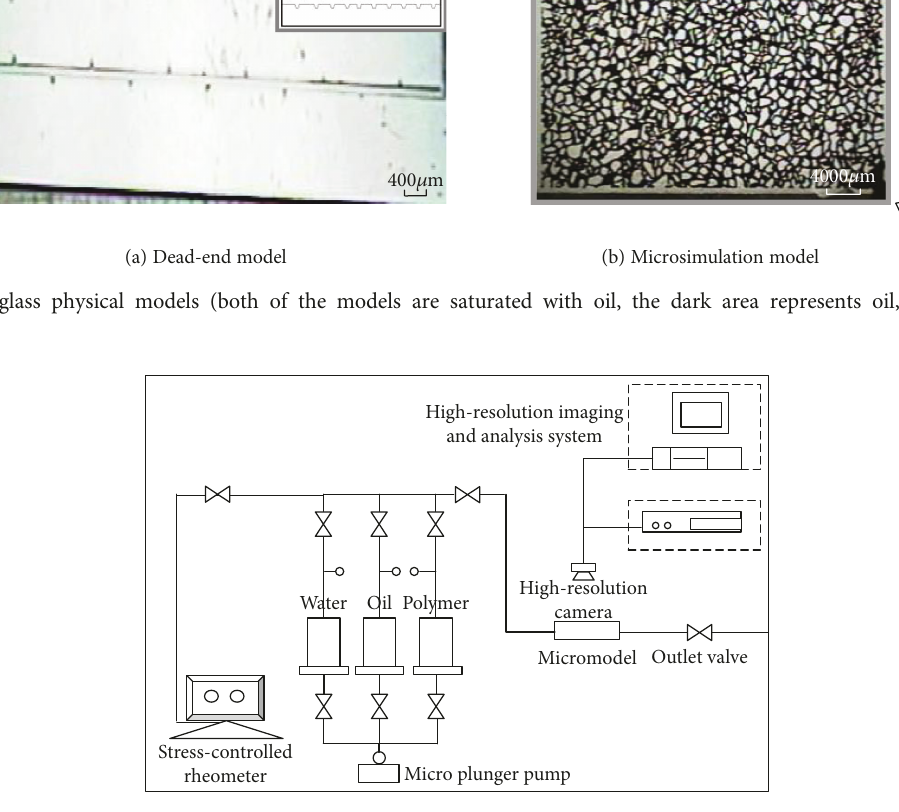
Figure 3: Schematic illustration of the equipment used in the microvisual displacement